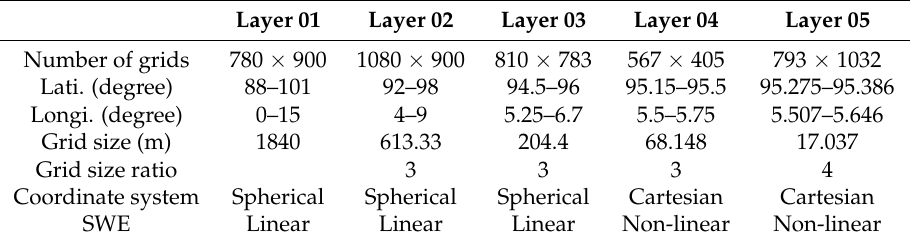
Figure 2. The initial condition (water surface elevation) for the 2004 Indian Ocean Earthquake. Table 1. Information on the setup of the five layers for